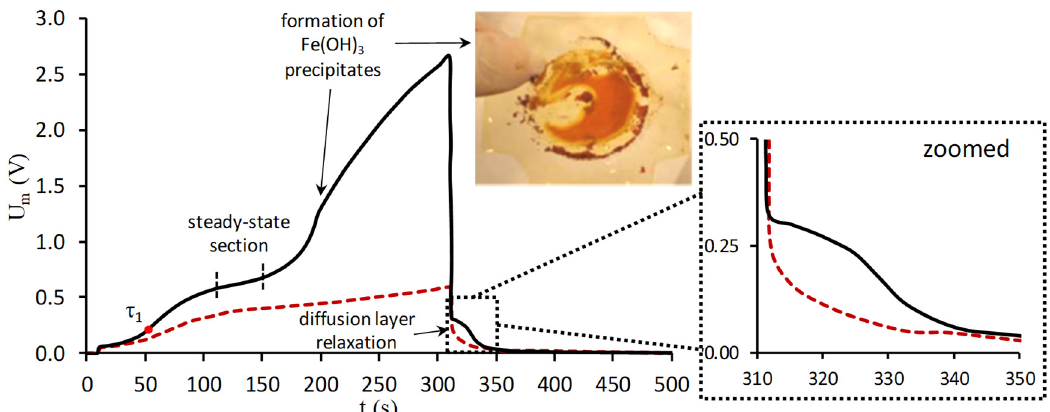
Figure 8. Chronopotentiometric curve of Nafion-117 membrane in 0.01 M Fe 2 (SO 4 ) 3 solution in overlimiting current regime. Dashed line shows a typical shape of the curve in NaCl solution. The inset shows the precipitate found on the studied membrane surface after obtaining the chronopotentiometric curve (optical image). Adapted from [176].